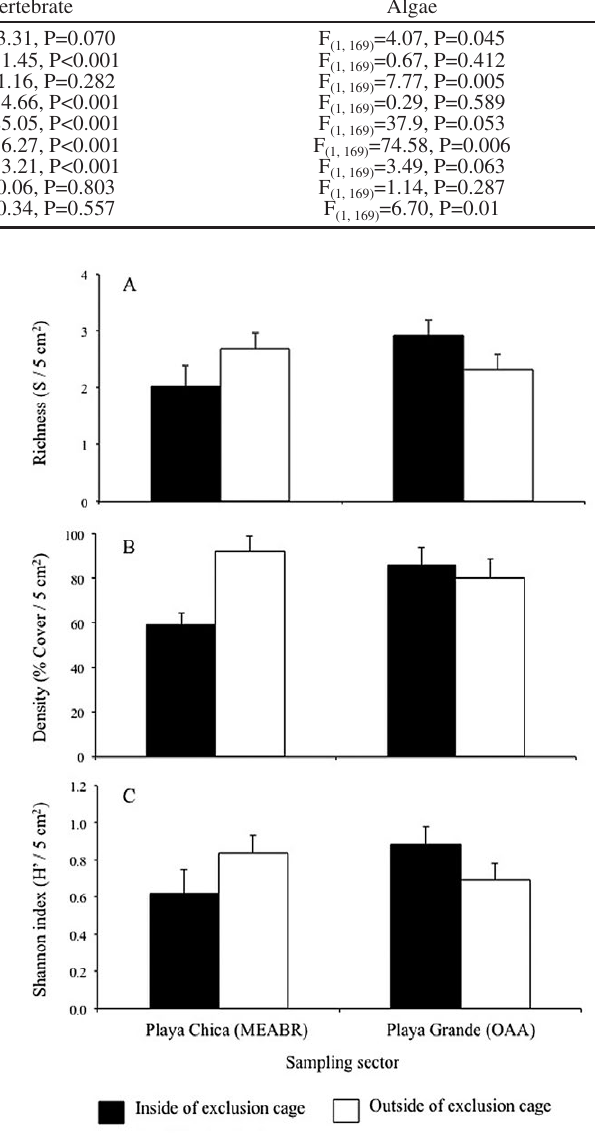
Fig. 2. – Algae community descriptors “inside” and “outside” exclu- sion cages in the MEABR and the OAA. (A) Species richness, (B) density and (C) algae diversity. Bars indicate SEM